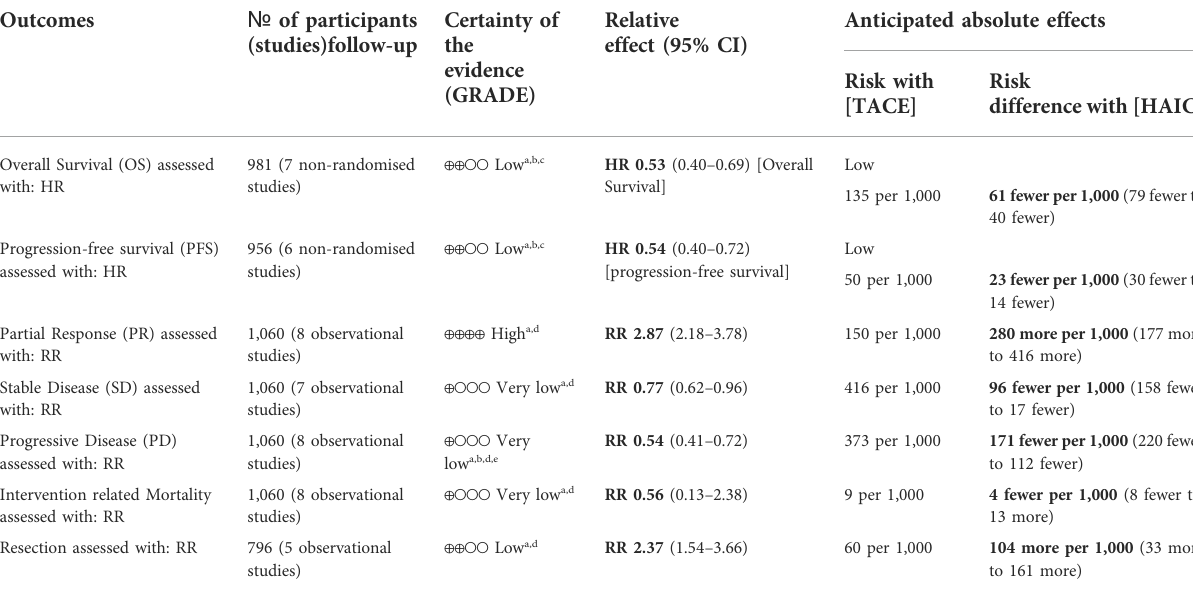
TABLE 4 Grade summary of fi nding table.